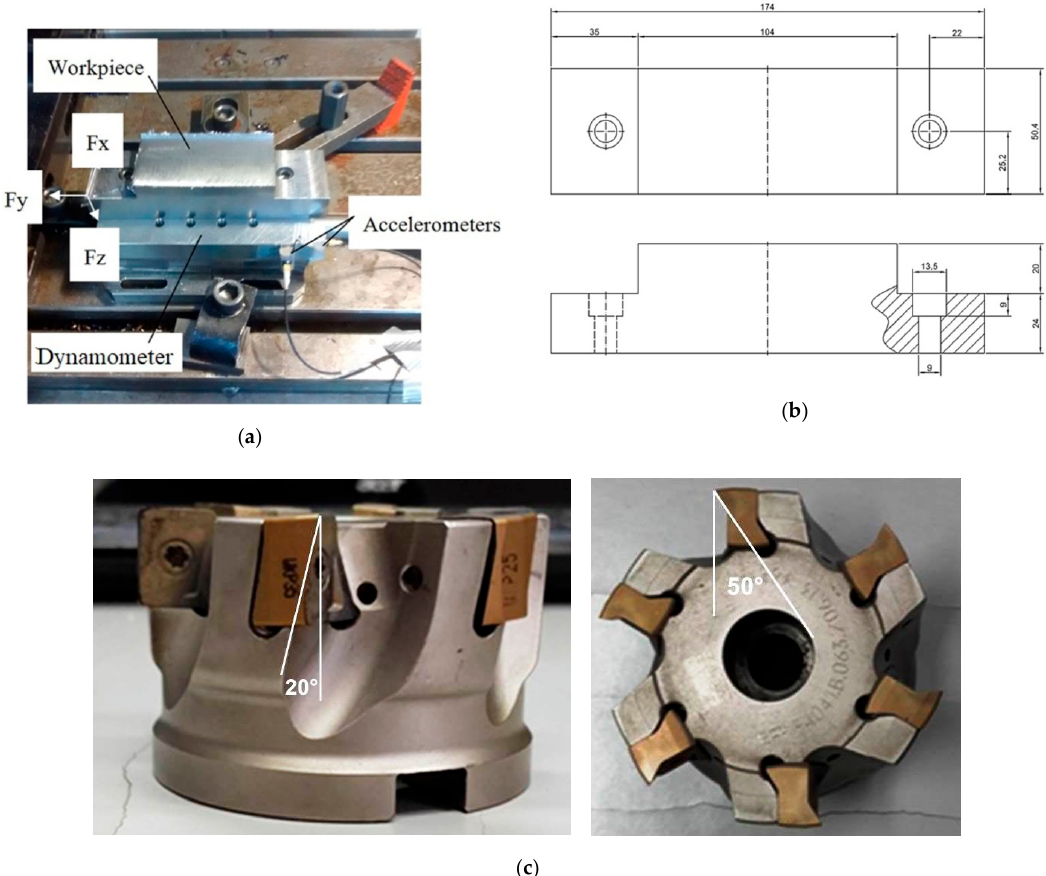
Figure 1. Experimental part: ( a ) Experimental setup, ( b ) workpiece specification, ( c ) milling cutter.